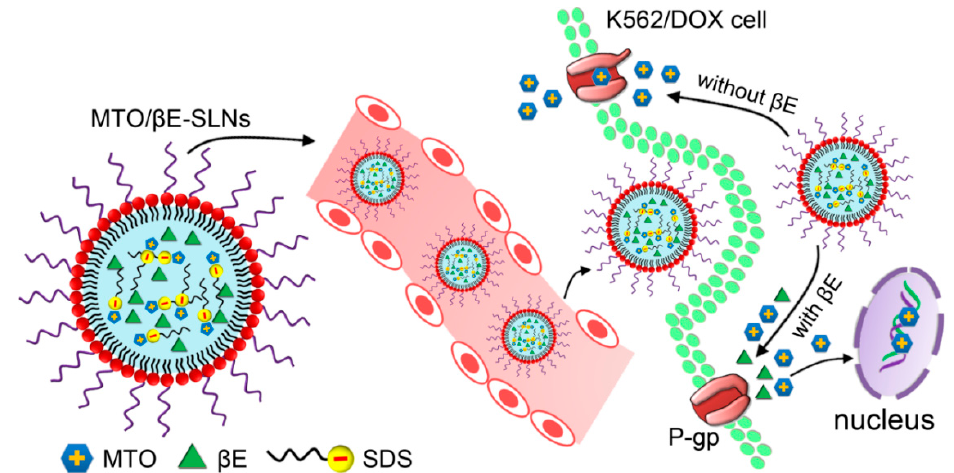
Scheme1. Schematic illustration of solid lipids nanoparticles for co-loading mitoxantrone (MTO)